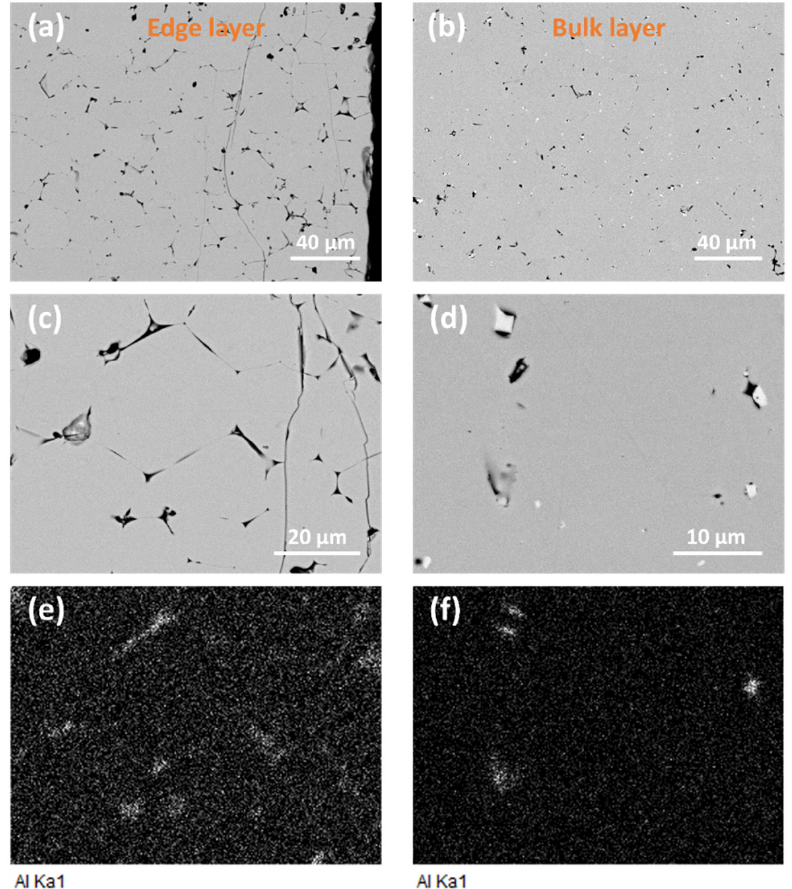
Figure 7. ( a – d ) Microstructure of 0.5 GAlN composite ceramics, ( e , f ) aluminum elemental maps, taken from images ( c ) and ( d ), respectively. taken from images ( c ) and ( d ),